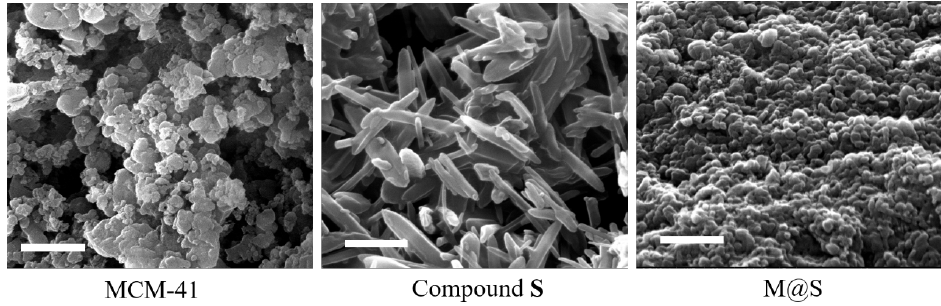
Figure 3. SEM images of MCM-41, compound S , and M@S. The scale bar is 500 nm in all